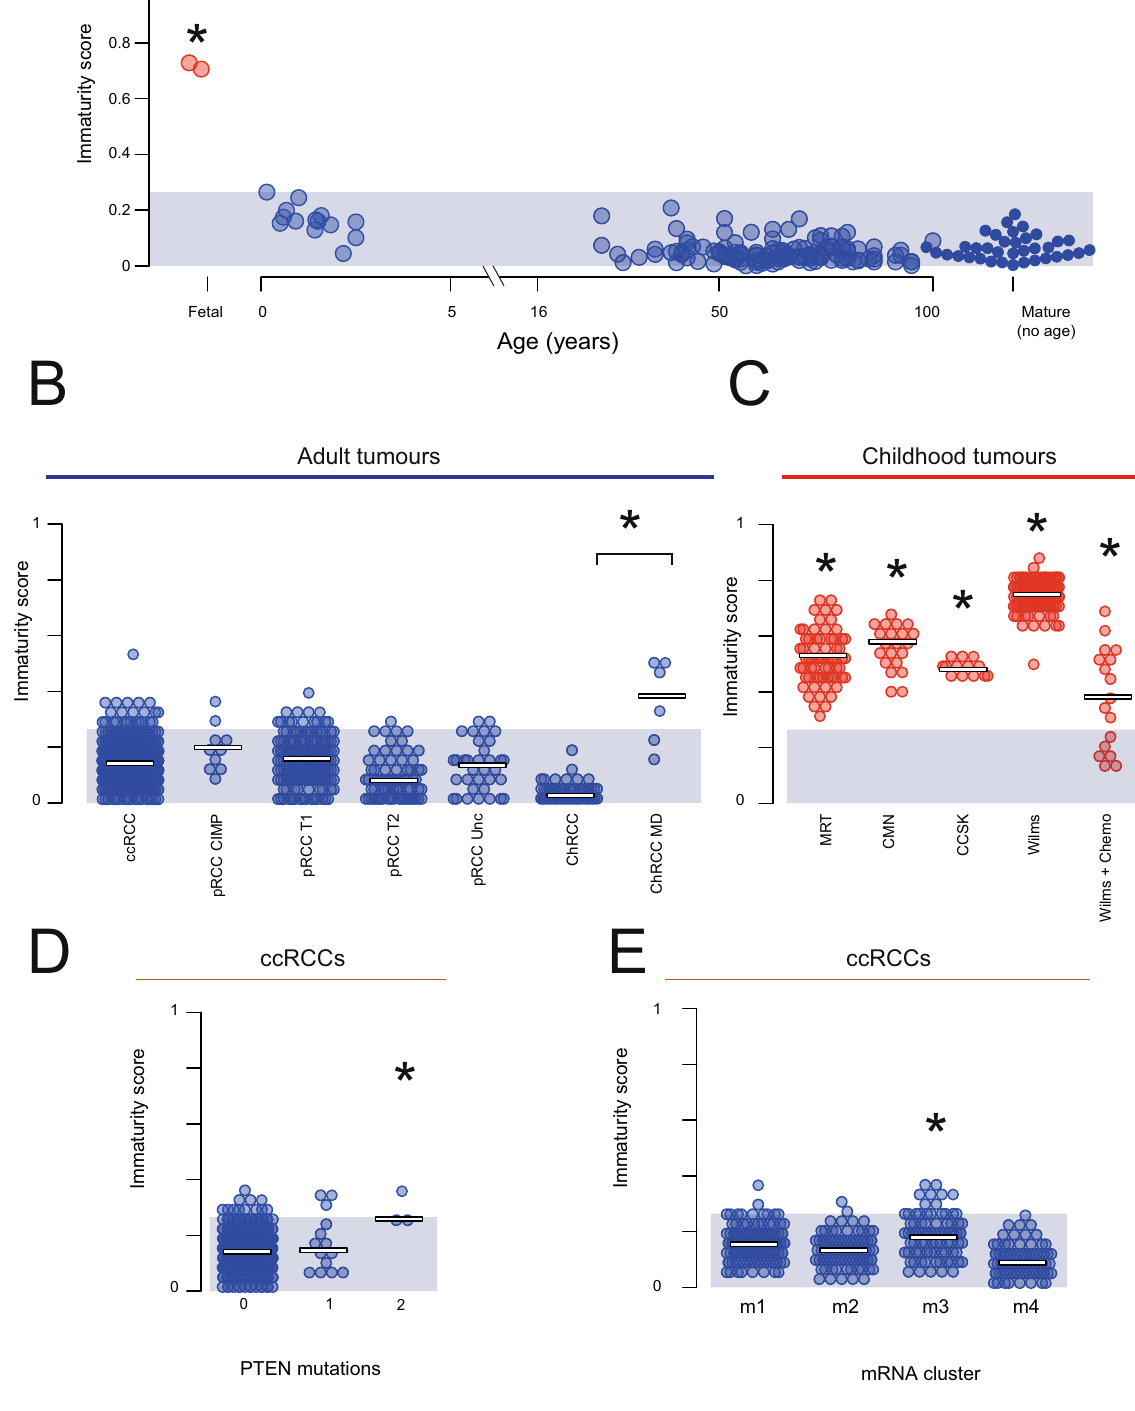
Wilms tumor, clear cell sarcoma of the kidney and the effect of treatment . Wilms tumor is the most common childhood kidney cancer and is thought to arise from aberrant cells of the devel- oping nephron. Clear cell sarcoma of the kidney (CCSK) is a rare, at times aggressive childhood renal cancer that is treated as a high risk Wilms tumor in clinical practice 23 . We assessed the